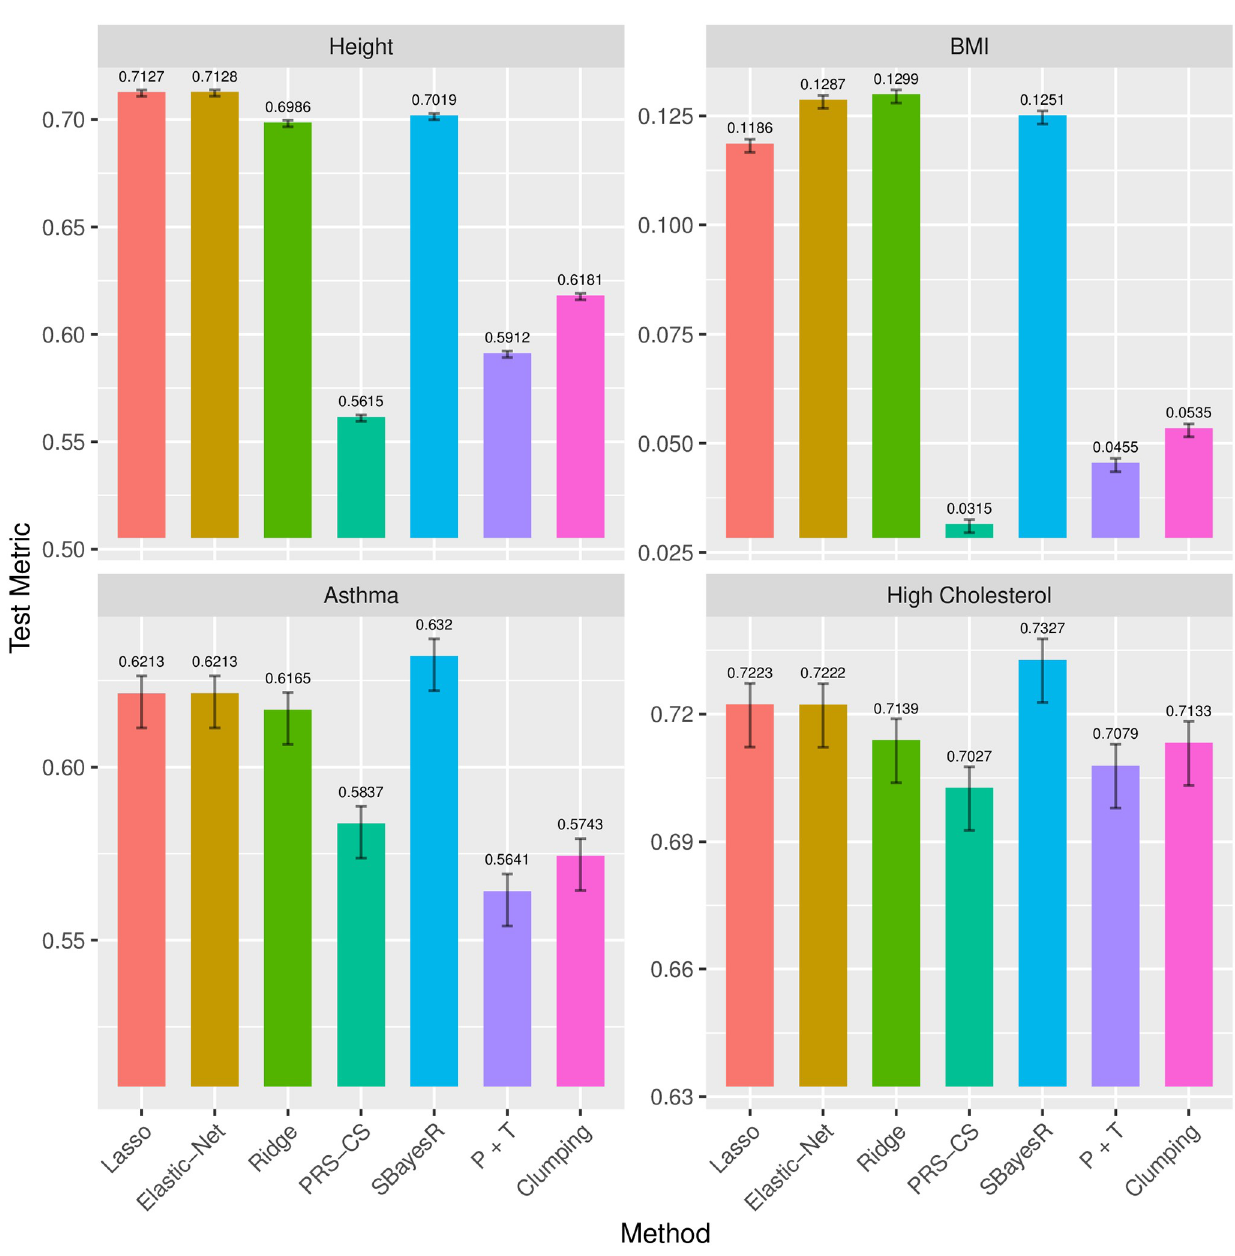
Fig 3. Comparison of the test set predictive performance of the different polygenic risk score (PRS) methods with refitting on the training and the validation set. R 2 are evaluated for continuous phenotypes height and BMI, and AUC evaluated for binary phenotypes asthma and high cholesterol. The error bar uses 2 standard errors to show the statistical